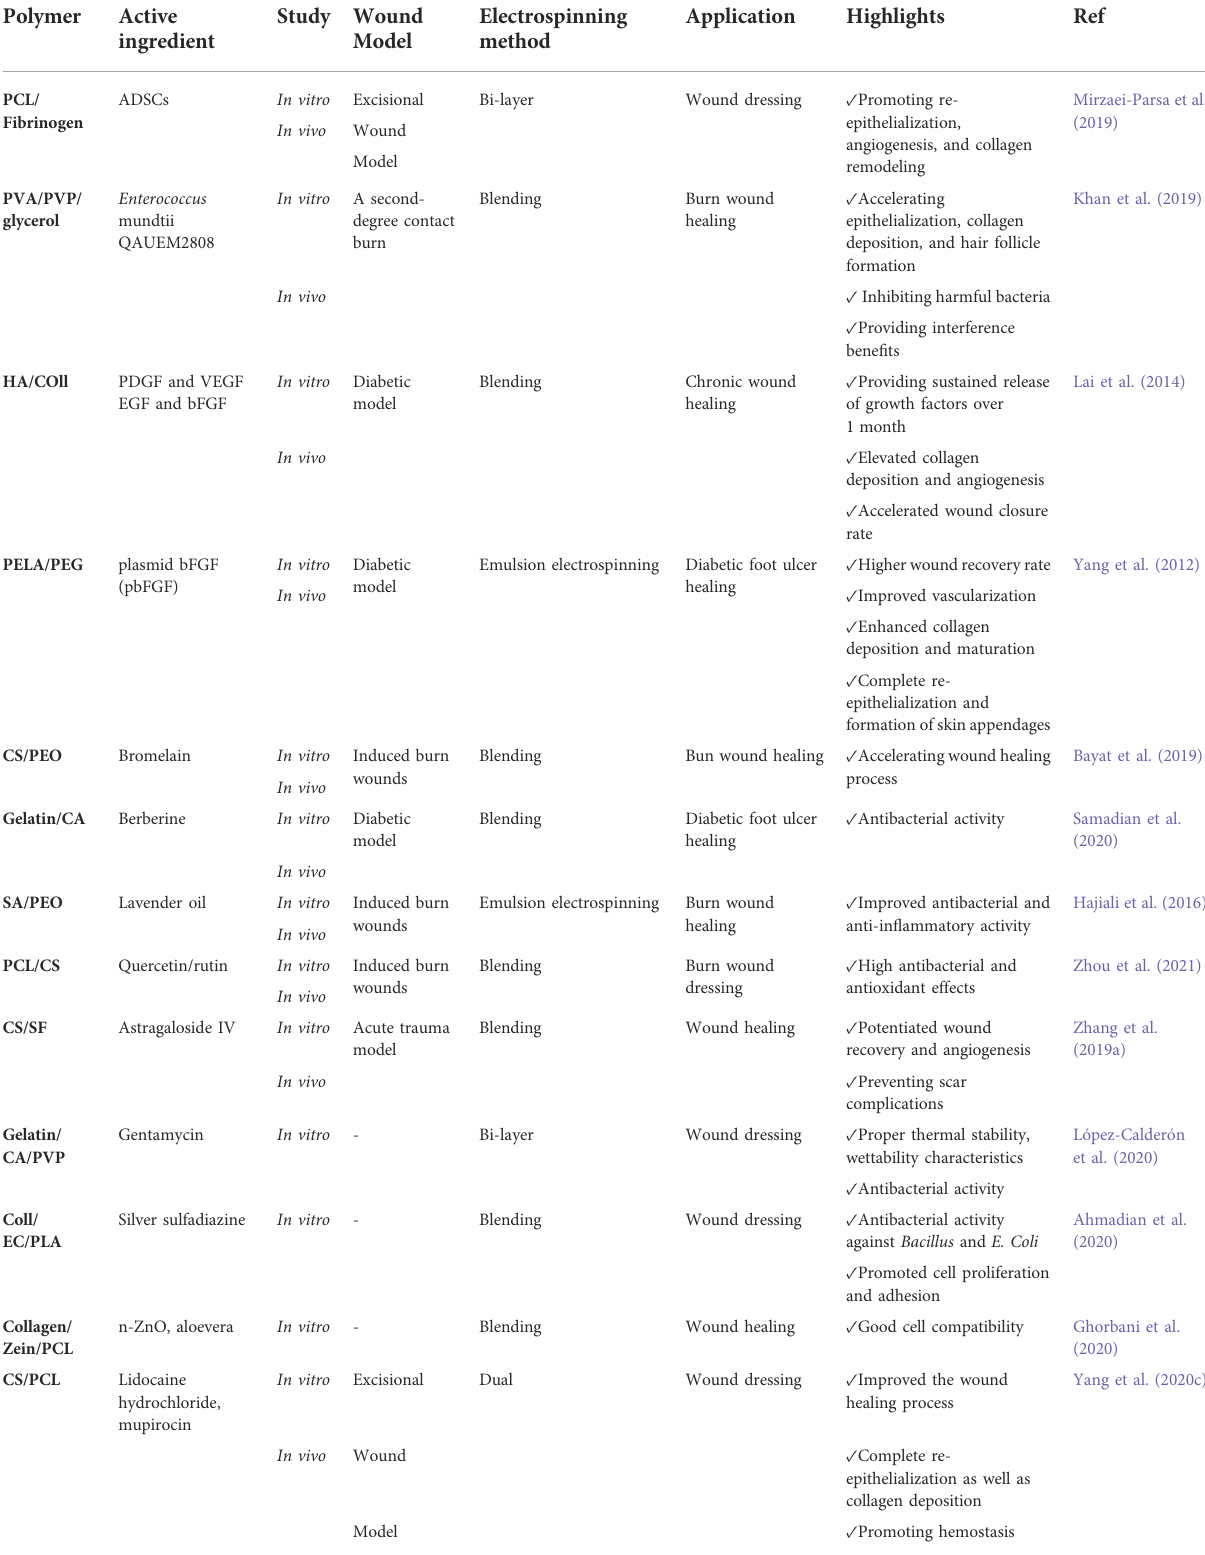
TABLE 9 An overview of electrospun hybrid nano fi ber for wound dressing.